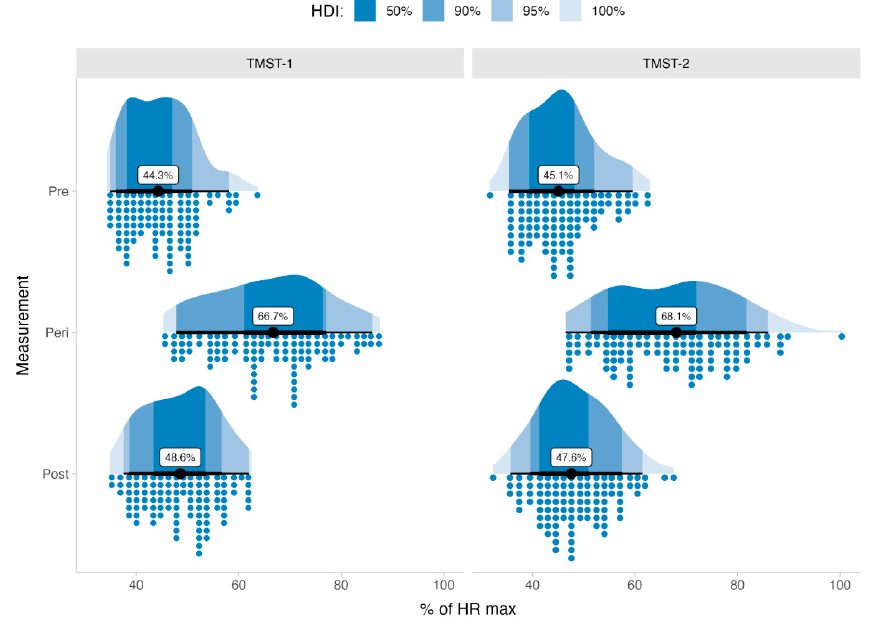
Figure 3. Raincloud plots of the mean heart rate for each measurement during both 2-min step test protocols. The black line at the center of each Raincloud plot represents the median value observed from the data.